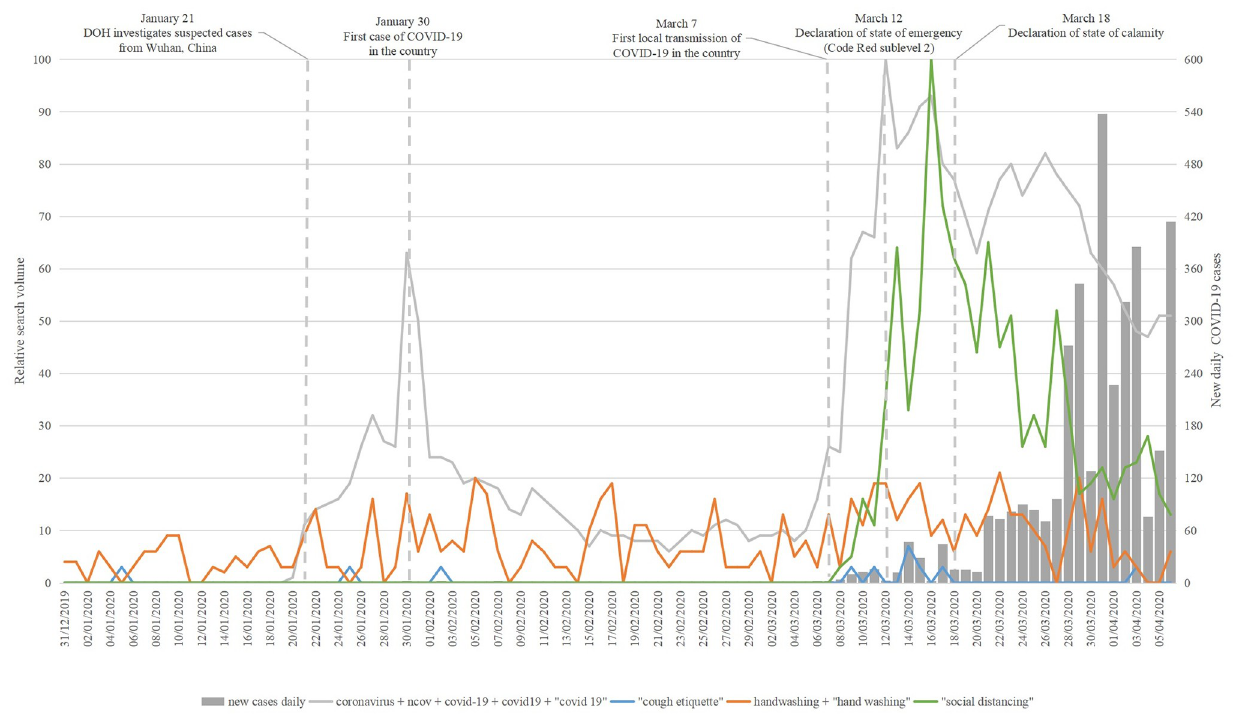
Fig 3. Search interests for personal protective